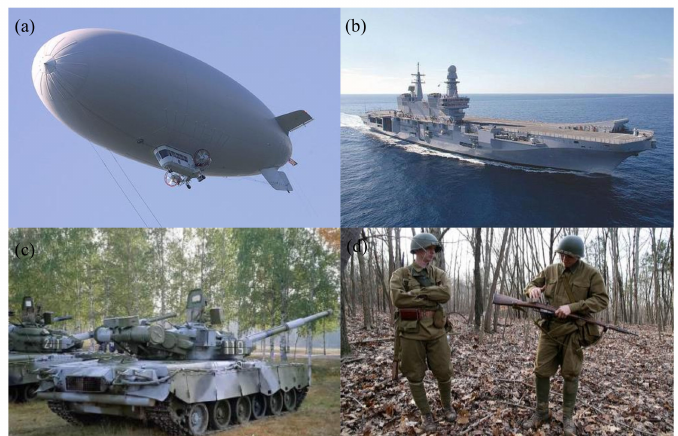
Figure 2. Data samples from the Imagenet2012 dataset. ( a ) airship; ( b ) aircraft carrier; ( c ) tank; ( d ) uniformed